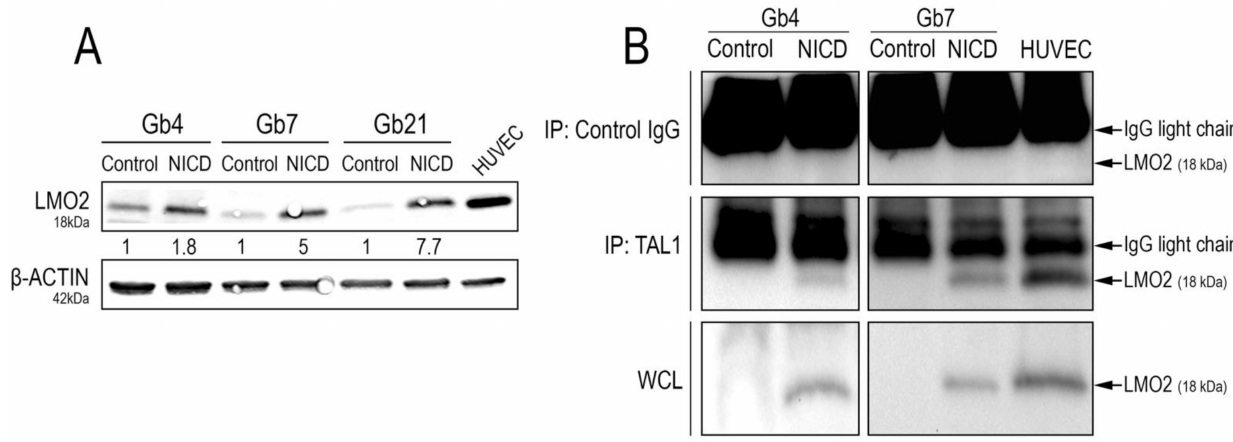
Figure 7. LMO2 upregulation and interaction with TAL1-PP22 upon Notch1 activation of GSCs. ( A ) WB images and quantifications showing LMO2 upregulation in Gb4, Gb7, and Gb21 upon Notch1 activation. HUVEC cells were used as a positive control for LMO2 expression ( n = 3, Figure S9D). ( B ) TAL1 Co-IP analyses showing an interaction between TAL1-PP22 and LMO2 in Gb4 and Gb7 cells upon NICD transduction. HUVEC cells were used as a positive control. Upper panels show LMO2 WB on control IP using IgG lysates, middle panels show LMO2 WB on TAL1-IP lysates, and lower panels show control LMO2 WB on whole cell lysates (WCL). Gb4 YFP/NICD WCLs and control IgG lysates were loaded on different gels. Given the low molecular weight of LMO2 (18kDa), IgG light chains are apparent on the blot above the LMO2 band. Images are representative of n = 2 experiments for Gb4 and n = 1 experiment for